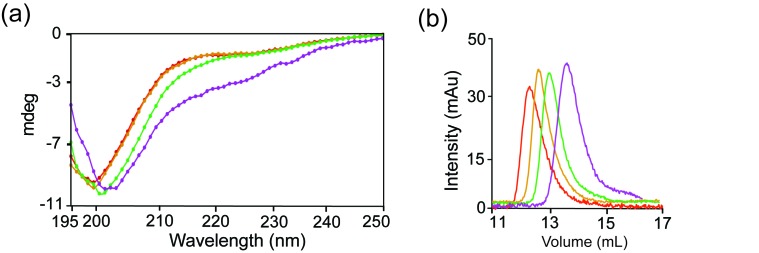
dLBD C-terminus is transiently compact.(a) Far UV CD spectrum of dLBD constructs collected at 10°C: QT1-3 (red), QT2-4 (orange), QT4-6 (green), and QT4-7 (magenta). (b) Size exclusion chromatography of each construct from (a) depicts differences in migration time, using the same color scheme. Size exclusion chromatography was performed on a Superdex 75 10/300 column.